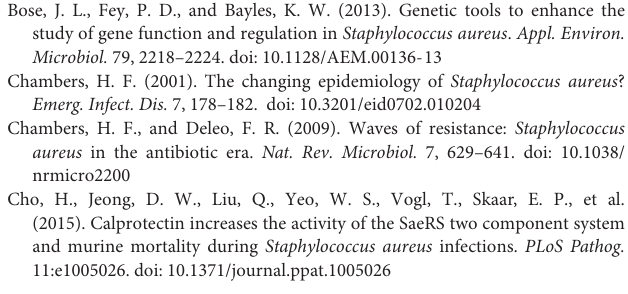
FIGURE S1 | Complementation of saeP and saeQ restores USA300 phenotype. Gene complementation with saeP and saeQ on the xylose-inducible pEPSA5 plasmid restores USA300 phenotype. Promoter expression induced with 2% (w/v) xylose in the medium. (A) Gene expression of saeP and saeQ is rescued in S. aureus mutant strains complemented with saeP or saeQ expressed in trans. (B) Complementation of saeP restores transcript of select S. aureus genes to levels observed in USA300 (or higher). Transcript abundance is relative to gyrB and calibrated to expression in USA300 ( n = 2/gene). (C) Complementation of saeP and saeQ in trans reduces secreted cytolytic factors that target neutrophil plasma membrane damage to levels secreted by USA300. Data are presented as the mean ± SEM of four independent experiments. Stats: One-Way ANOVA with Tukey’s post-test; ns, not significant. FIGURE S2 | Deletion of saeP or saeQ did not significantly impact abscess area. Deletion of saeP or saeQ did not significantly impact abscess area. (A) BALB/C mice (5 per group) and (B) C57BL/6 mice (5 per group) were infected subcutaneously with 1 × 10 7 CFUs of each S. aureus strain and abscess area was subsequently monitored for 10 days. Abscess area was measured daily and results shown are the average area per strain. Representative images are from C57BL/6 mice on day 2. Graphs represent data from two biological replicates for BALB/c and one for C57BL/6. Unpaired t -test relative to USA300, ∗ p -value ≤ 0.05, ∗∗ p -value ≤ 0.01. Data are presented as the mean ± SEM. FIGURE S3 | The (cid:49) saePQ mutant has reduced saeR/S transcript levels but induces Sae-dependent genes normally. (A,B) Normalized transcript abundance is shown for USA300 and the indicated mutant strains of S. aureus grown to exponential phase using SYBR green qRT-PCR as described in Materials and Methods and as described in Mlynek et al. (2018). Data indicate the mean ± SEM from three independent experiments. Statistical analysis: ANOVA (ordinary one-way), Dunnett’s multiple comparison test, asterisks indicate the level of significance compared to the USA300 ( P ≤ 0.05). For USA300 (cid:49) saePQRS , the transcript level is below the limit of detection. (C) The indicated strains carrying a nuc-gfp reporter fusion were grown to exponential phase (OD 600 ∼ 0.4) in dilute Luria broth, at which time bacteria were exposed to either vehicle (water) or HNP-1 for 12 h. The data shown are the mean relative fluorescence units (RFUs; fluorescence/OD 600 ) ± SEM for three independent experiments performed in technical triplicate; statistical significance was assessed by paired t -test ( ∗ P ≤ 0.05, ∗∗ P ≤ 0.01, ∗∗∗ P ≤ 0.001). ND, not detected: signal was below the limit of detection. FIGURE S4 | Deletion of saePQ influences lesion structure and nuc expression in infected kidneys. (A–F) Representative confocal micrographs of staphylococcal lesions in kidney produced by USA300 and USA300 (cid:49) saePQ . Channels: nuc-sGFP (A,D) , DAPI (B,E) , and merge (C,F) (scale bar is 25 µ m). The fluorescence image acquisition parameters used are as follows; excitation for DAPI (blue) and GFP (green) are 405 and 488 nm respectively; emission ranges are 419–481 nm (DAPI) and 505–551 nm